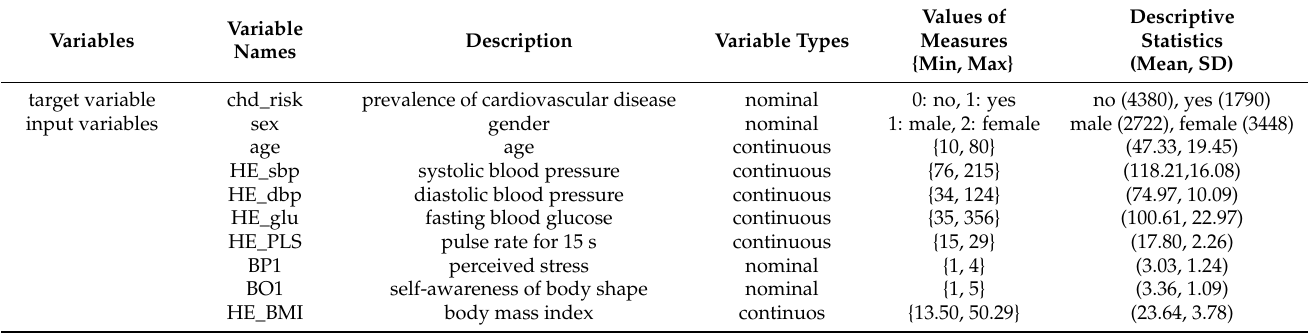
Table 1. Description of variables.